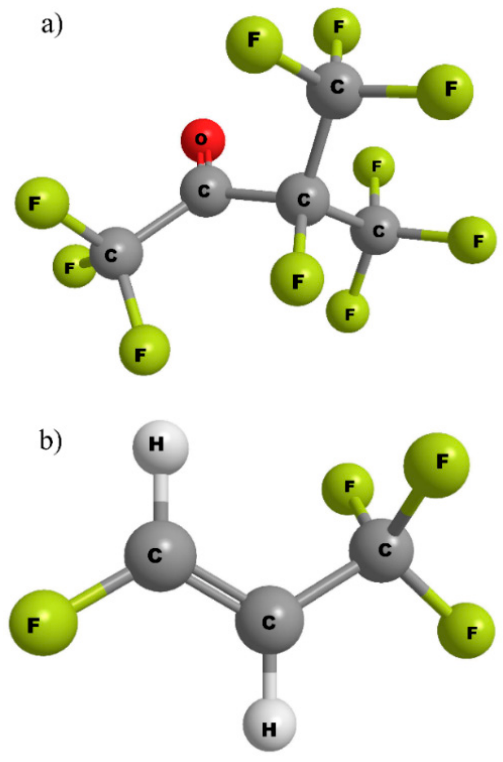
Figure 1. Molecular structures of ( a ) C 5 F 10 O (PFK5) and ( b ) C 3 F 4 H 2 (HFO3E) .